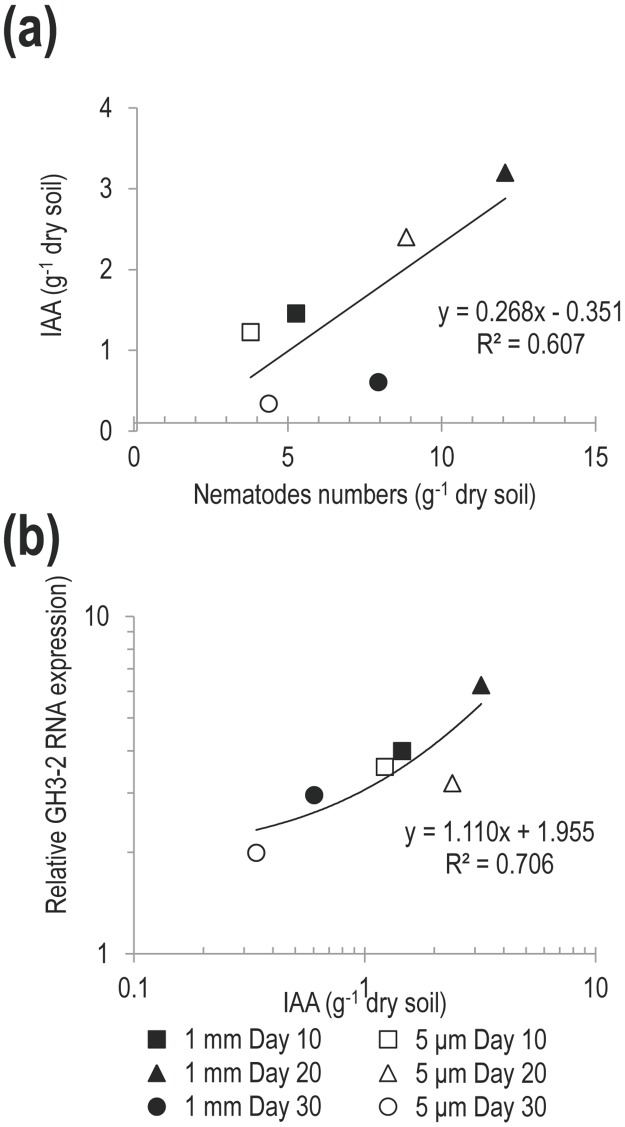
Relationship between soil IAA content and (a) Nematode abundance or (b) relative GH3-2 expression in rice roots.1mm: soil contains more bacterial-feeding nematodes than 5 μm: see text for details.